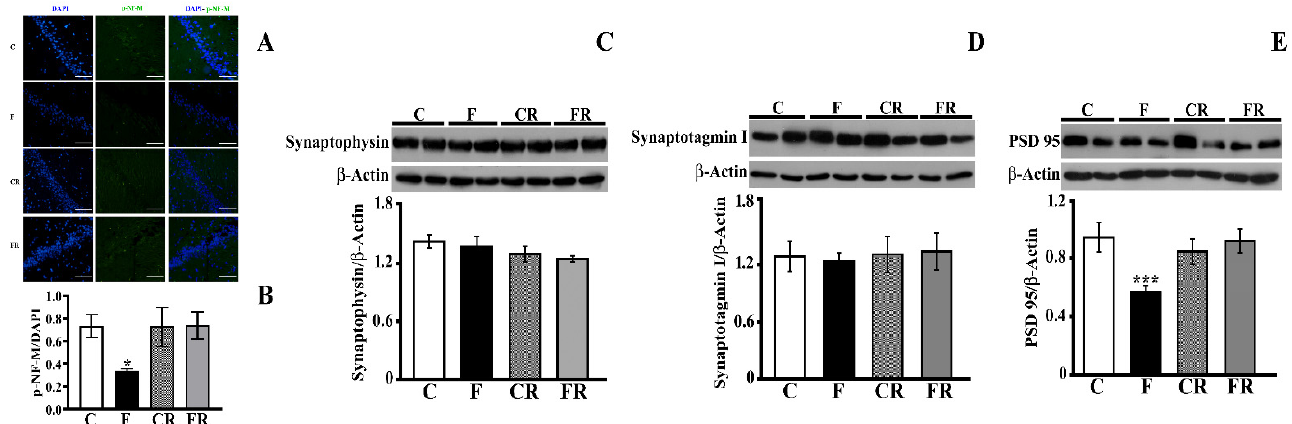
Figure 7. Markers of neuronal functioning. ( A,B ) p-Neurofilament M immunofluorescence ( C ) synapthophysin level (with representative Western blot), ( D ) synaptotagmin I (with representative Western blot), ( E ) PSD 95 level (with representative Western blot) in the hippocampi of control (C), fructose-fed (F), control rescued (CR), and fructose-rescued (FR) rats. Data are the means ± SEM of eight rats/group. * p < 0.05 versus control rats; *** p < 0.001 versus control rats. Source of variation: one-way ANOVA followed by Tukey post-test.